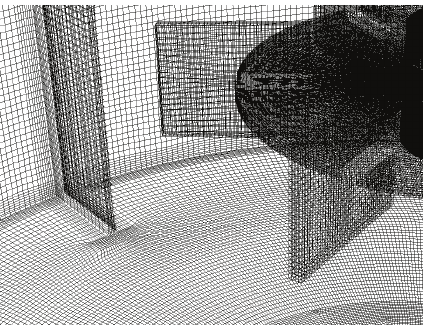
Figure 1: Mesh in the baffles vicinity and on the impeller surface in detail (LES 1).